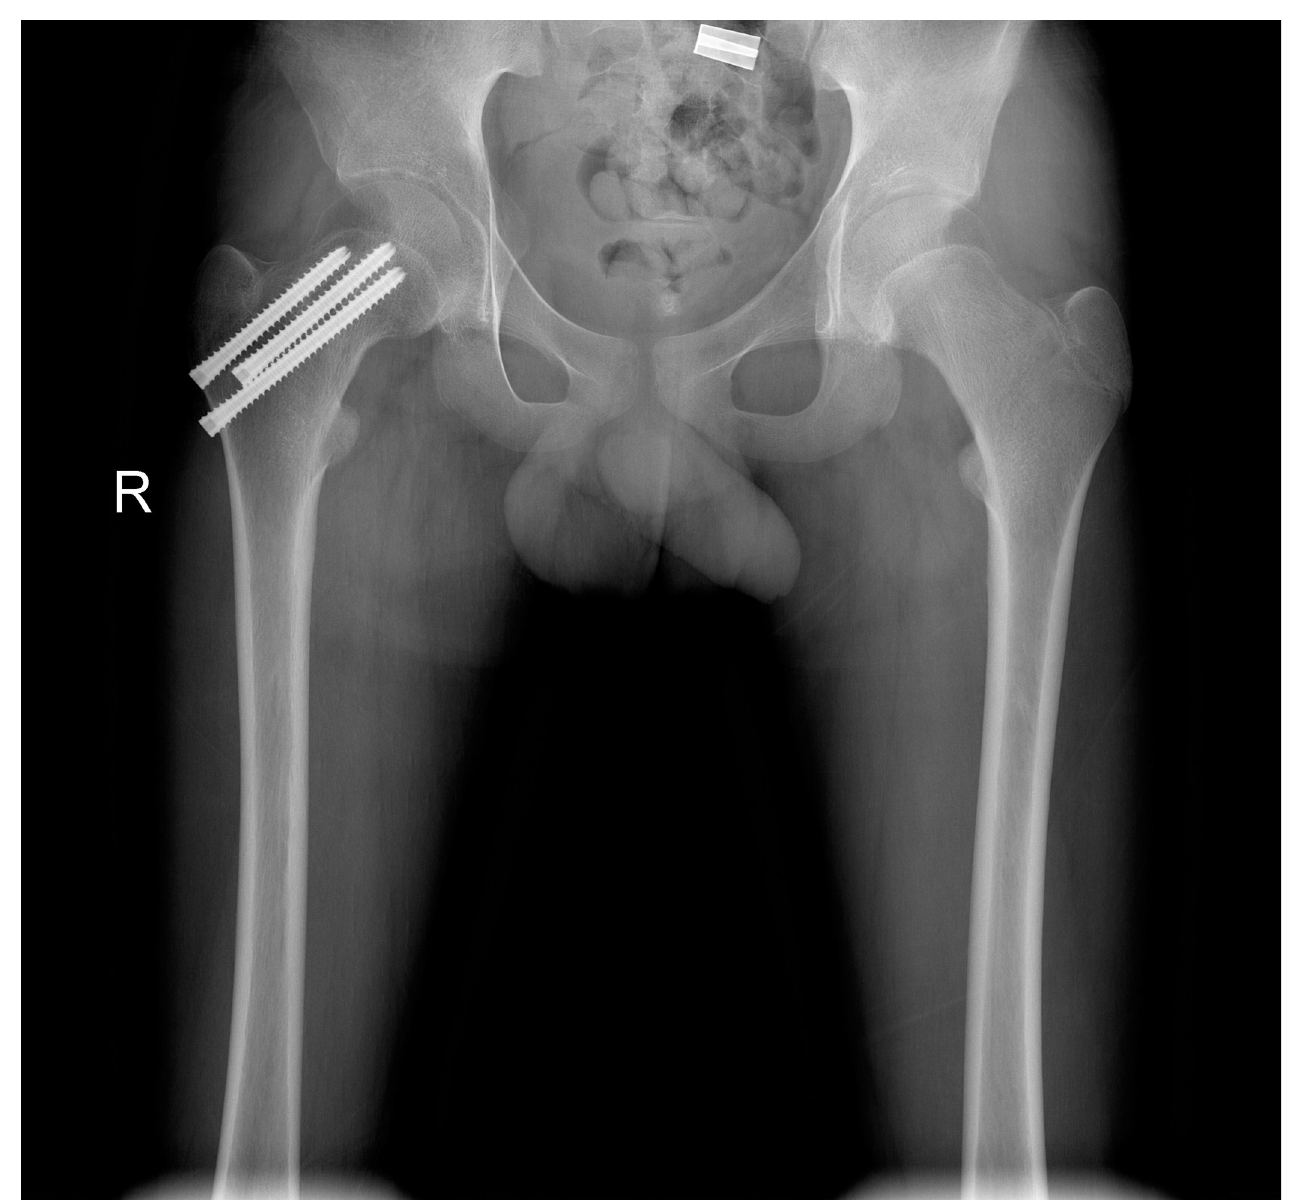
Fig 6. The last follow-up evaluation at 12 months postoperatively. Radiograph reveals regular femoral head morphology, uniform density, and no avascular necrosis of the femoral head.